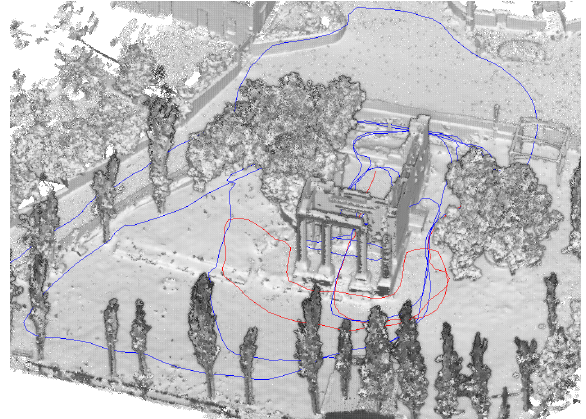
Figure 6. Trajectories followed while scanning the environment with the HERON Lite system. The red one was performed keeping the sensor with an inclination of approximately 45° to better record the upper parts of the temple.